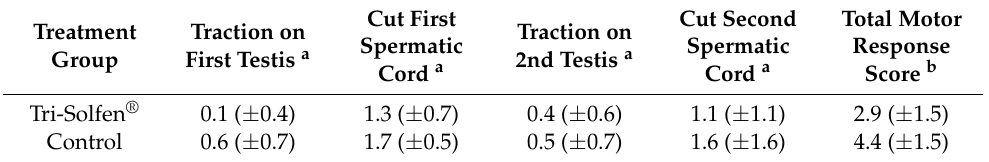
Table 3. Mean ( ± standard deviation) nociceptive motor response during piglet castration between Tri-Solfen ® treated and untreated control